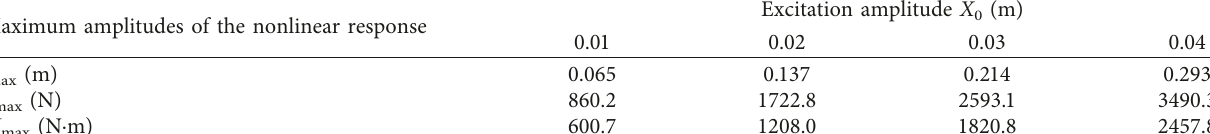
� 0 . 8 m and z � 0 . 7 1 1